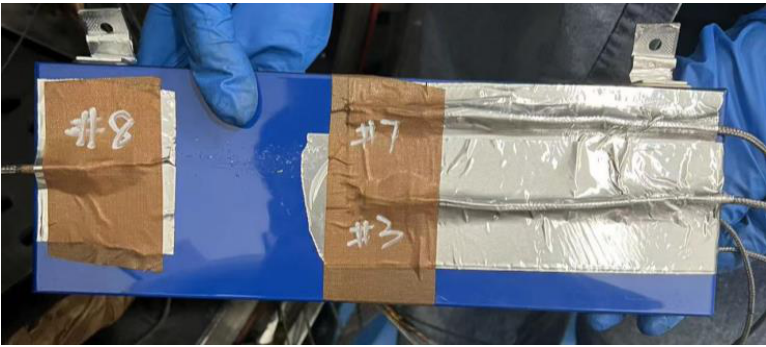
Figure 2. Experimental device structure diagram.